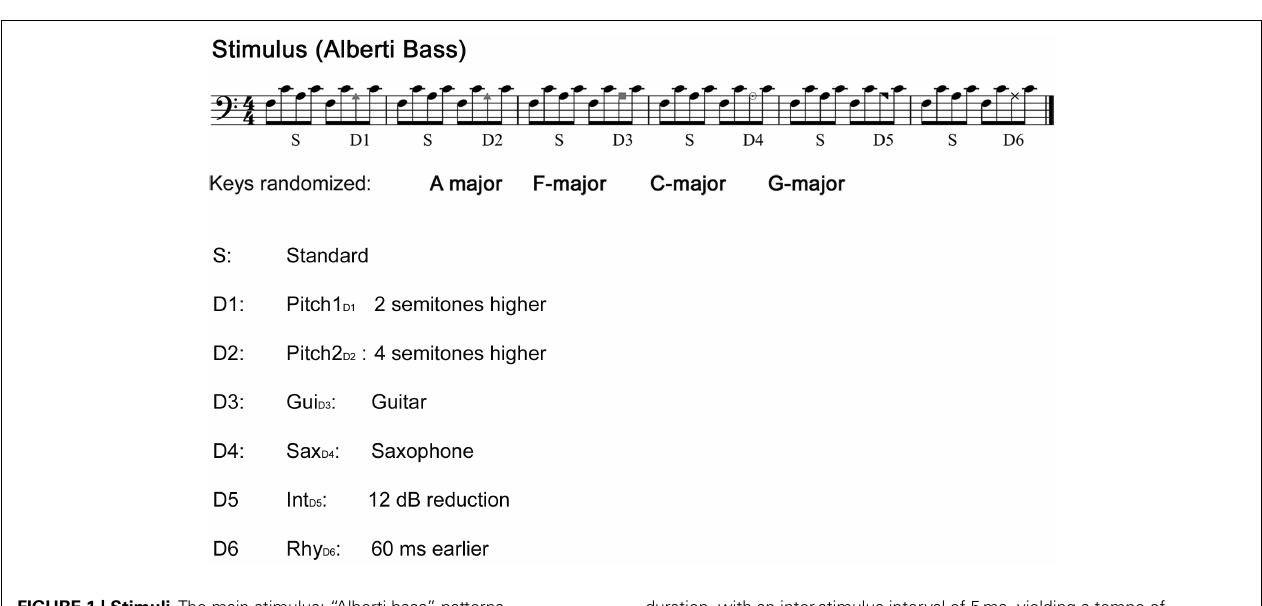
duration, with an inter-stimulus-interval of 5ms, yielding a tempo of approximately 140 beats/min. Comparisons were made between the third note of the standard sequence and the third note of the deviant